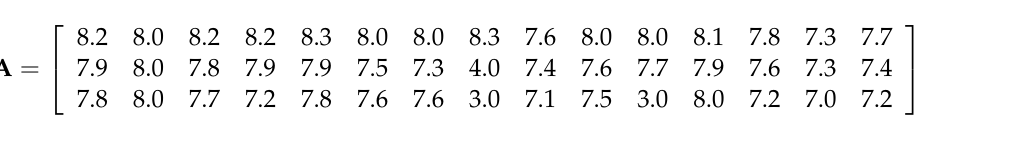
Table 2. Initial evaluation value of